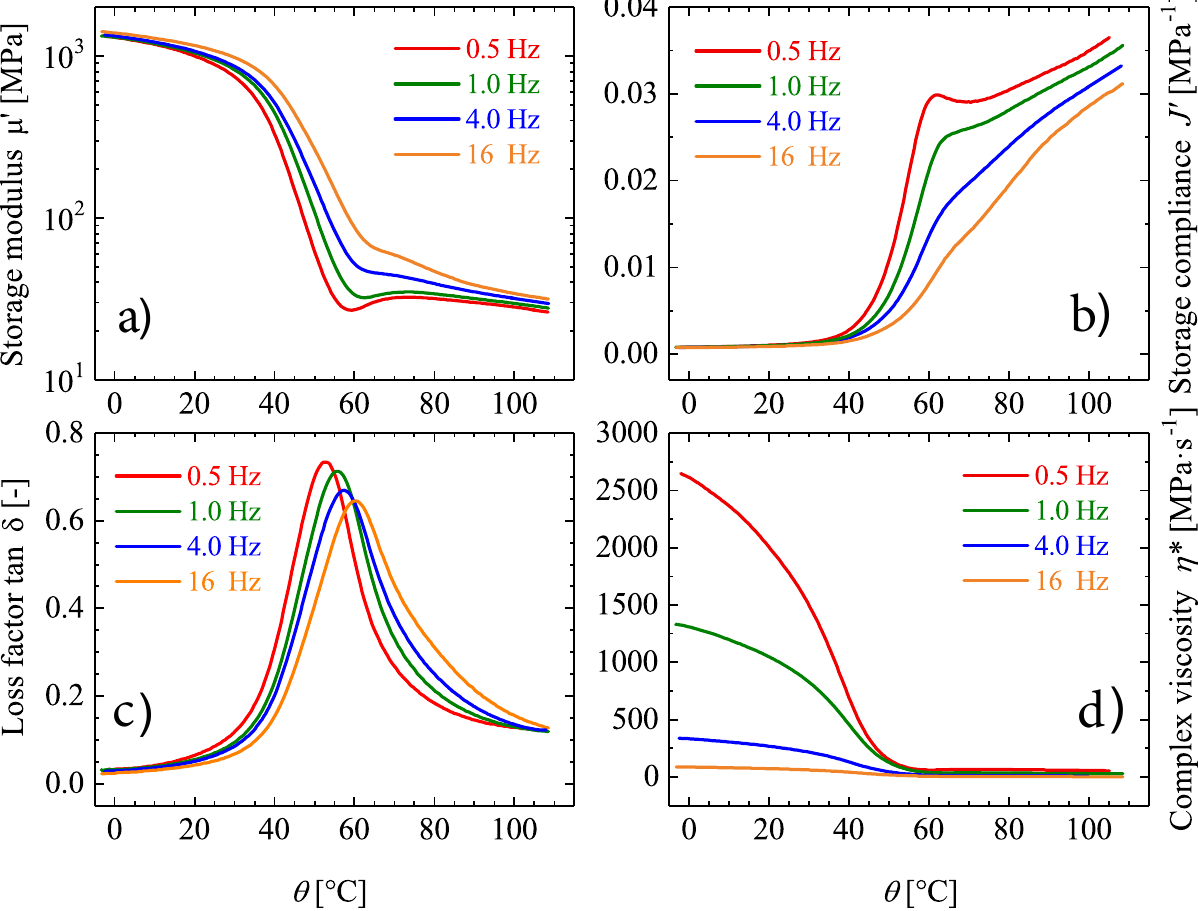
Figure 4. ( a – d ): Comprehensive thermo-rheological characterization of Estane during temperature sweep test from 50 to 110 ◦ C with different frequencies ranging from 0.5 to 16